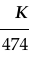
Table 8. Swift constitutive equation coefficients of material 5754O.